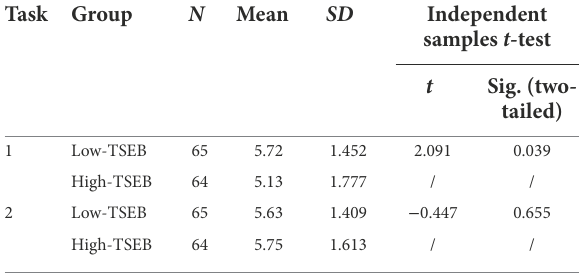
TABLE 5 Independent samples t -test for performance subscale.